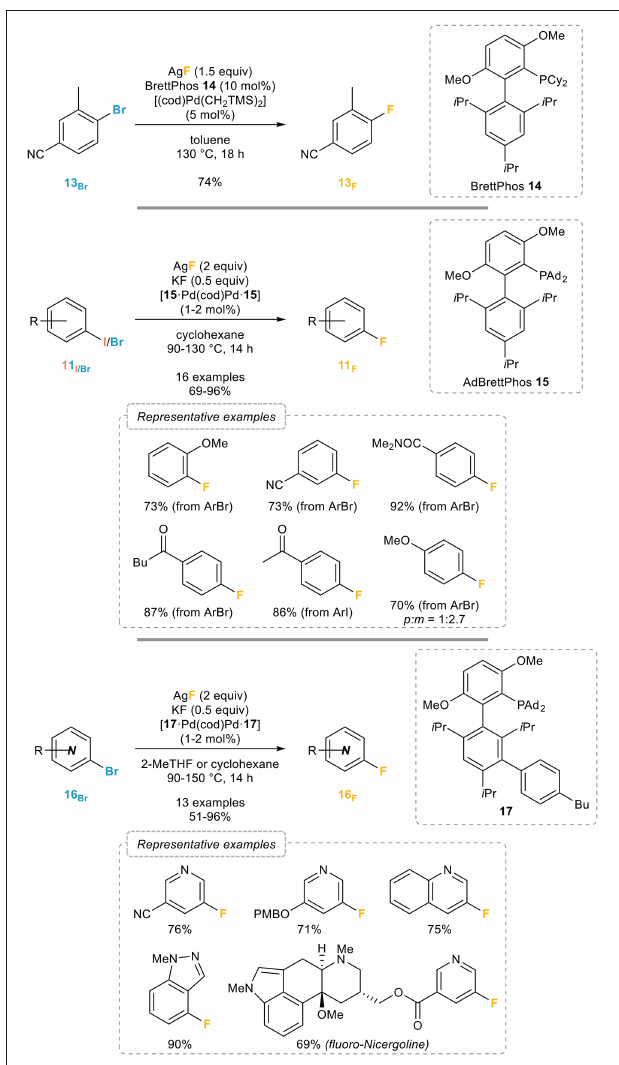
FIGURE 12 | Palladium-catalyzed fluorination of aryl